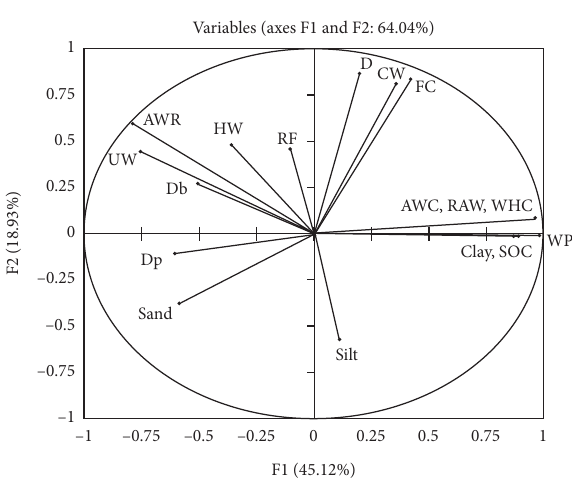
Figure 4: Graphical representation of the first two principal components of soil and moisture characteristics. Extraction method: principal component analysis ( n �